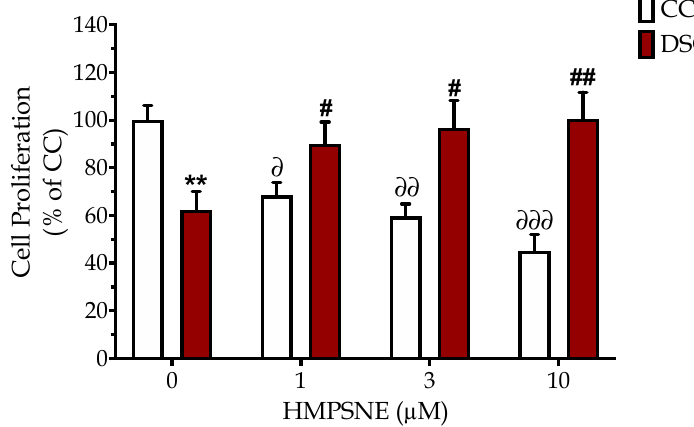
Figure 4. The 3-MST inhibitor HMPSNE concentration-dependently restores the cell proliferation rate in Down syndrome cells. BrdU incorporation assay was used to quantify cell proliferation of normal Detroit 551 (CC) and Down syndrome Detroit 539 (DSC) fibroblasts under baseline conditions and when treated with 1, 3 or 10 µM HMPSNE for 24 h. Each bar represents the mean ± SEM from at least 3 independent experiments. ** p < 0.01 indicates that baseline cell proliferation was significantly lower in DSCs than in CCs; ∂ p < 0.05 ∂∂ p < 0.01 and ∂∂∂ p < 0.001 indicate the significant inhibitory effects of HMPSNE on the proliferation of CCs; # p < 0.05 and ## p < 0.01 indicate the significant stimulatory effect of HMPSNE on the proliferation of DSCs.